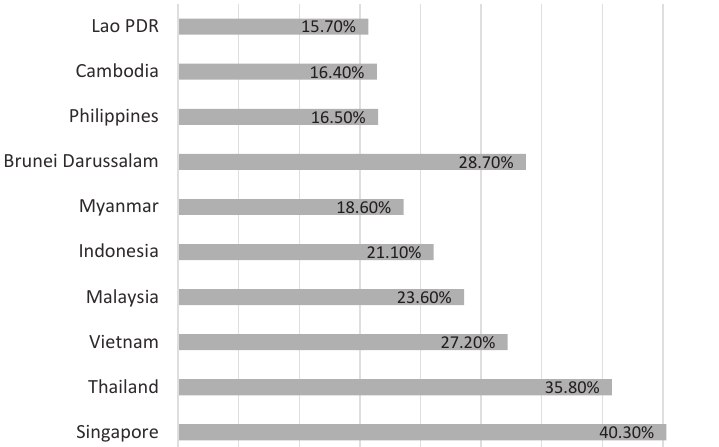
Figure 2. Share of